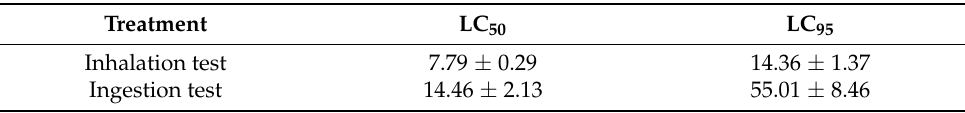
Table 6. Lethal concentrations of D. viscosa EO against C. maculatus. Results are expressed as mean ± SD.